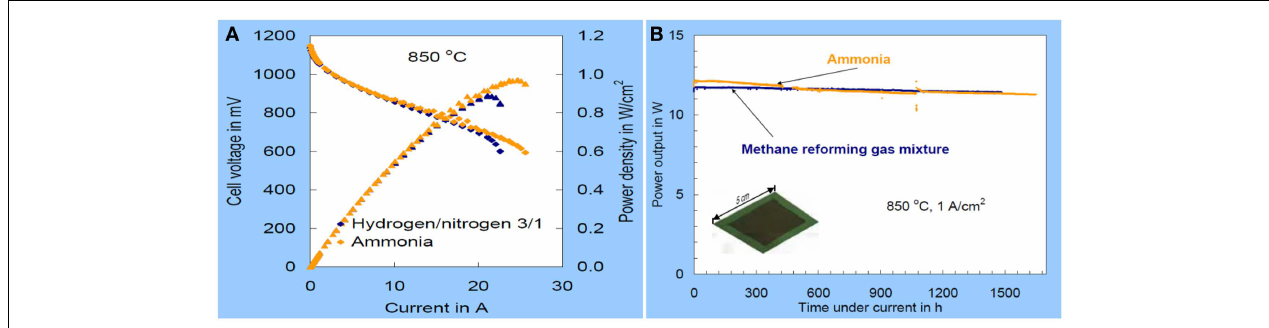
FIGURE 2 |The Current-voltage and power output curves for the use of ammonia or a corresponding hydrogen/nitrogen mixture as fuel at 850°C (A) and power output using ammonia as fuel on an 5cm × 5cm SOFC at 850°C, 1A/cm 2 current density, ~75–80% fuel utilization (B) (Hagen, 2007)